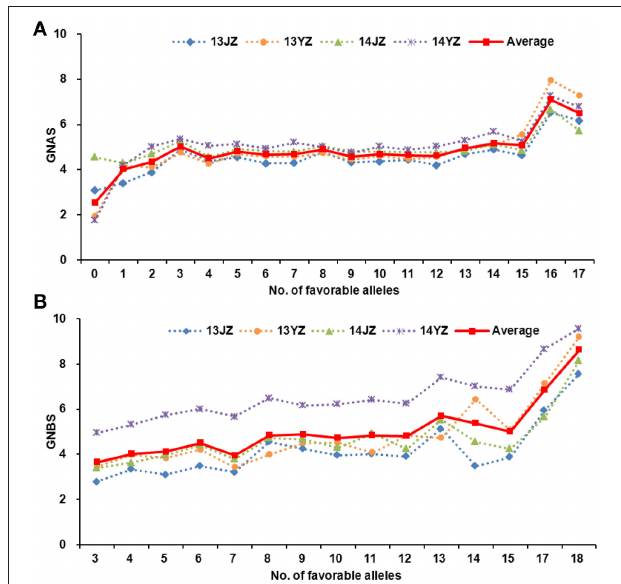
FIGURE 4 | Relationships between grain numbers in apical and basal spikelets and the number of favorable alleles. (A) The relatedness between the grain numbers in apical spikelets and number of favorable alleles. (B) The relatedness between the grain numbers in basal spikelets and number of favorable